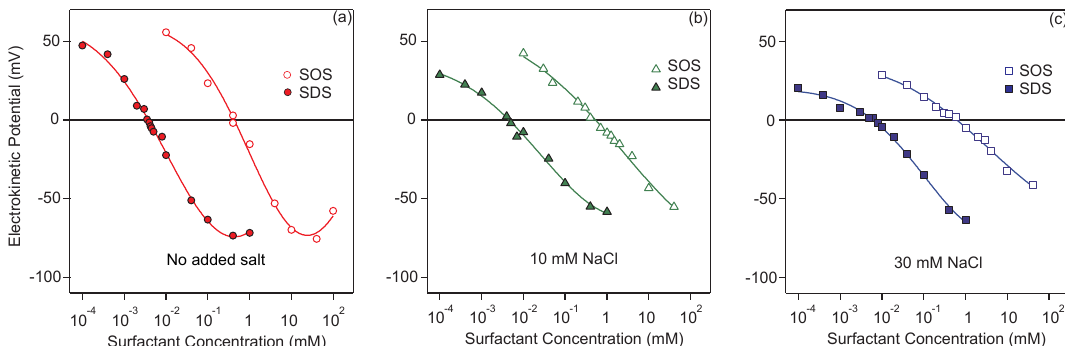
Figure 3. Electrokinetic potential of amidine latex particles as a function of surfactant concentration with ( a ) no added salt, ( b ) 10 mM NaCl, and ( c ) 30 mM NaCl. Empty symbols represent SOS and full symbols SDS surfactants. The lines are empirical interpolation